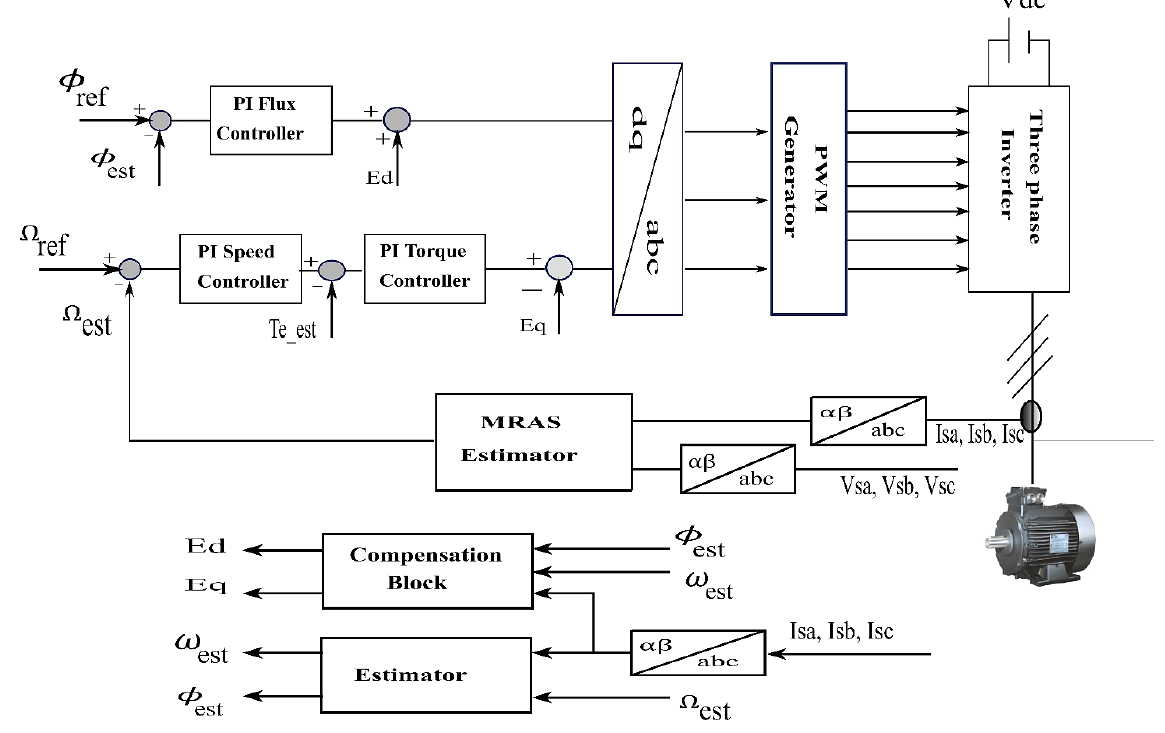
Figure 5. Synoptic diagram of the speed sensorless vector control